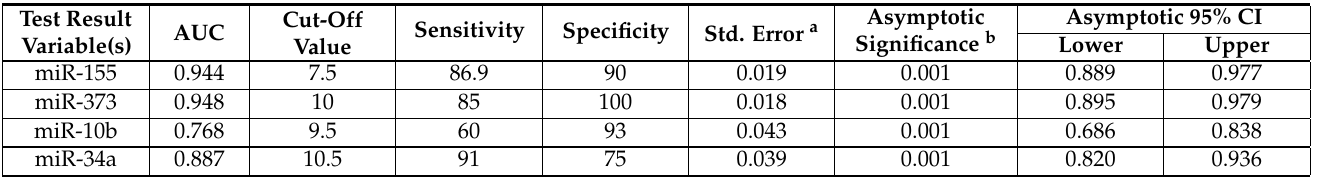
Table 2. AUC for the four miRs included in the